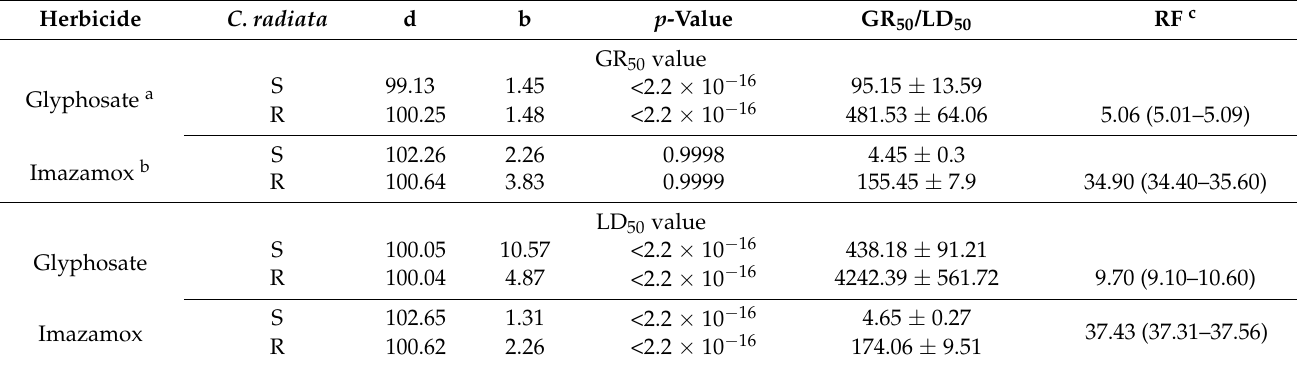
Figure 1. Effects of the glyphosate and imazamox dose on the dry weight reduction ( A , B ) and plant survival ( C , D ) of the untreated (control) Chloris radiata S ( ○ ) and R ( ∆ ) populations, expressed as a percentage of the mean ( n = 10) ± SE. Table 3. Parameters of the log ‐ logistic equation used to calculate the herbicide dose required for a 50% reduction in dry weight (GR 50 ) and lethal dose (LD 50 ).